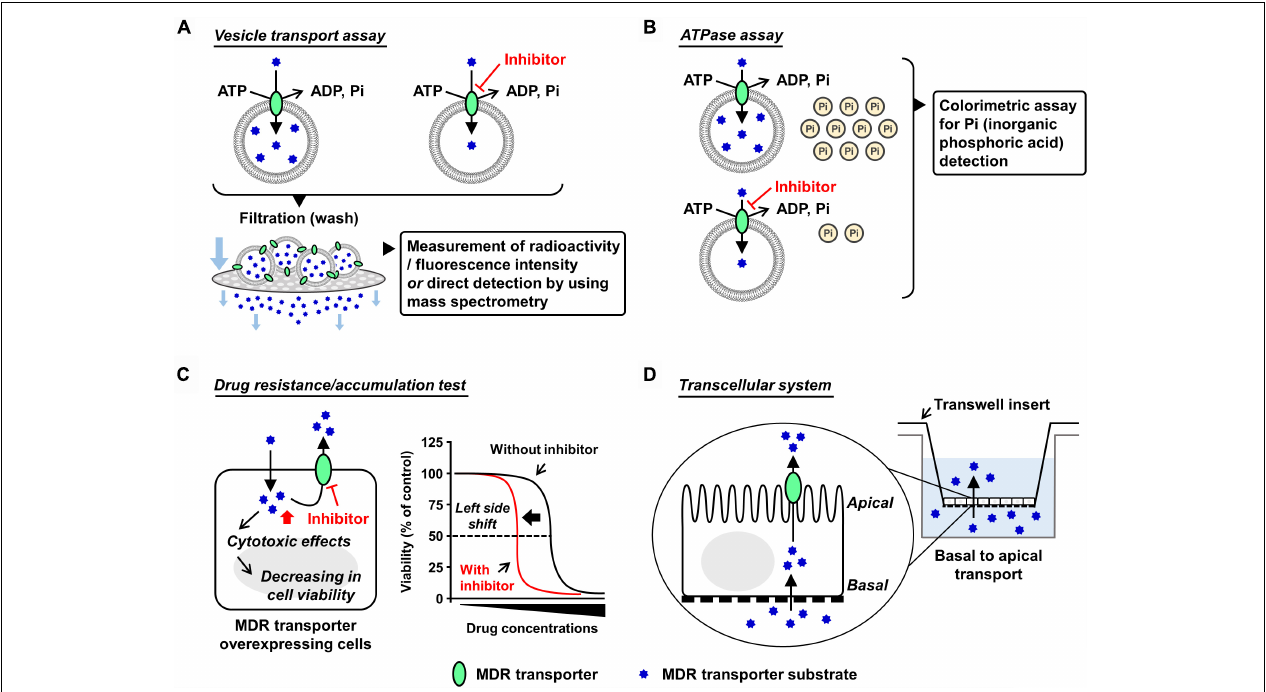
FIGURE 1 | Schematic illustrations of each in vitro assay. Generally used in vitro models which are classified into membrane-based systems and cell-based systems (Hegedus et al., 2009) are shown. In the former systems, investigators can use culture cell-derived plasma membrane vesicles or reconstituted proteoliposomes as described in the main text. In the latter systems, aside from a couple of exceptions using Xenopus laevis oocytes (Nakanishi et al., 2003; Woodward et al., 2009), mammalian cells expressing target ABC protein are generally used. (A,B) Plasma membrane vesicle- or proteoliposome-based methods: vesicle transport assay (A) and ATPase assay (B) . Both plasma membrane vesicles and reconstituted proteoliposomes are applicable to the vesicle transport assay and the ATPase assay. Of note, the final step of the vesicle preparation—gentle homogenization of isolated membrane fraction—is empirically important for the formation of inside-out plasma membrane vesicles, whose outer faces are the cytoplasmic aspects of the parent membranes. Although the resulting plasma membrane vesicles are the mixture of inside-out and right-side-out components, without any separation of the right-side-out vesicles they are generally stored at –80 ◦ C and subjected to further assays. This is because that in these in vitro assays, only ABC proteins embedded in the inside-out vesicles have their ABCs outside of the vesicles and can use ATP in the reaction mixture for their transport function. In other words, the ABC proteins in the right-side-out vesicles cannot work due to an inaccessibility of the ABCs with ATP. Additionally, ABCG2-enriched plasma membrane vesicles are used for a biochemical analysis to study interactions of candidate chemicals with ABCG2 at the substrate-binding sites, known as the photoaffinity labeling of ABCG2 with [ 125 I]-iodoarylazido-prazosin (Shukla et al., 2006). (C,D) Cell-based methods: drug resistance/accumulation test (C) and transcellular system (D) . MDR, multidrug